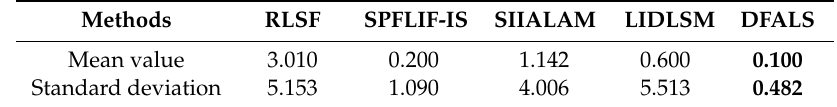
Table 2. The mean value and standard deviation of P g given by di ff erent methods on the test images in %.